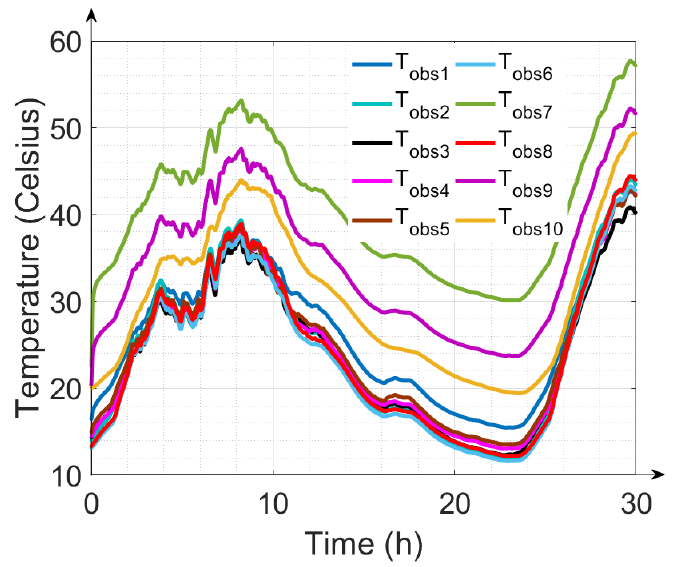
Figure 6. Time series of observed temperature T obs obtained for calibration measurement #16. The 10 temperature sensors were spread across the EMI instrument and measured temperature variation in the instrument.